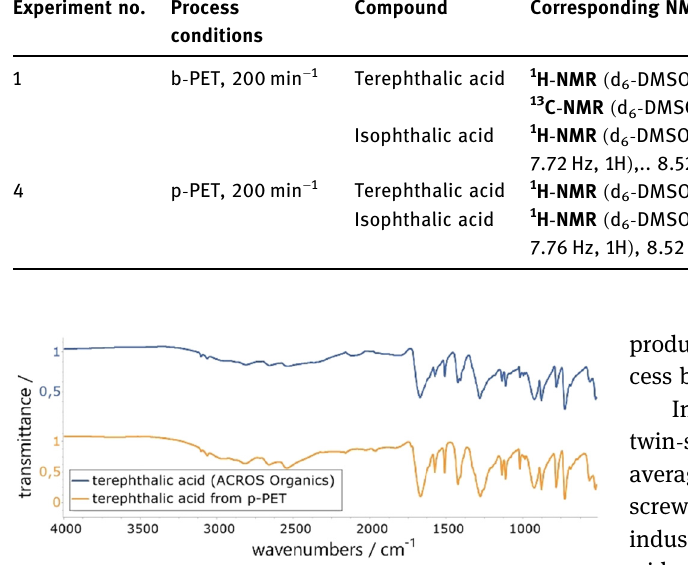
Figure 10: FT - IR - spectra of the obtained terephthalic acid in com - parison with the terephthalic acid standard.